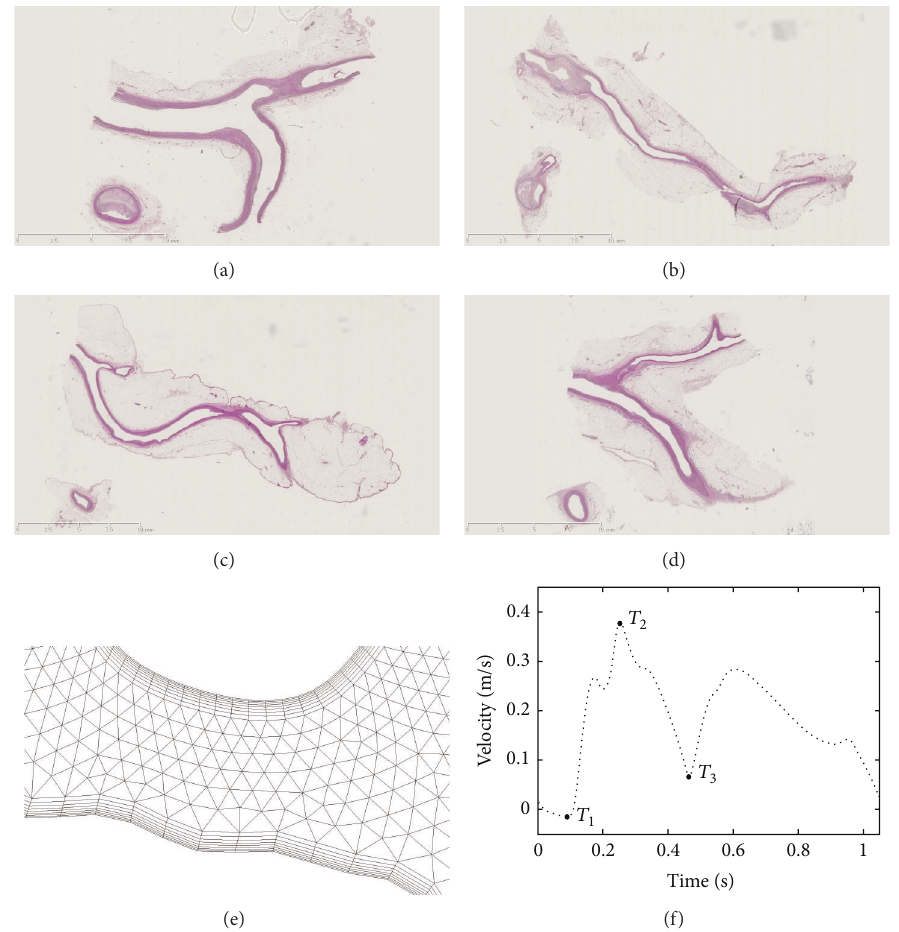
Figure 1: (a)–(d) LS images of four diseased coronary arteries, (e) the computational meshes at the stenosis location, and (f) velocity pulse at the